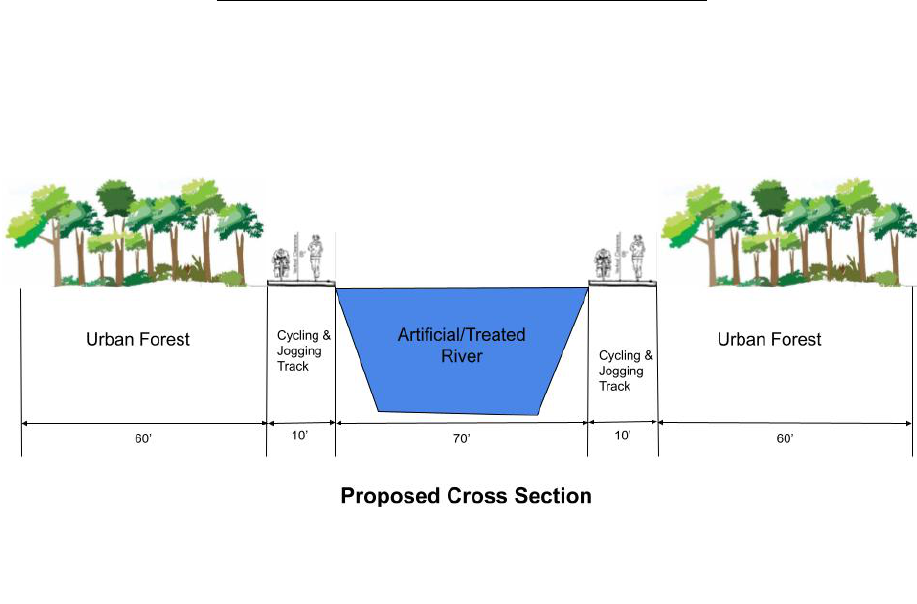
Figure 2: Cross-section of the Urban Treated River, Jogging Track, and Urban Forest to giveperspective of reuse of the river banks